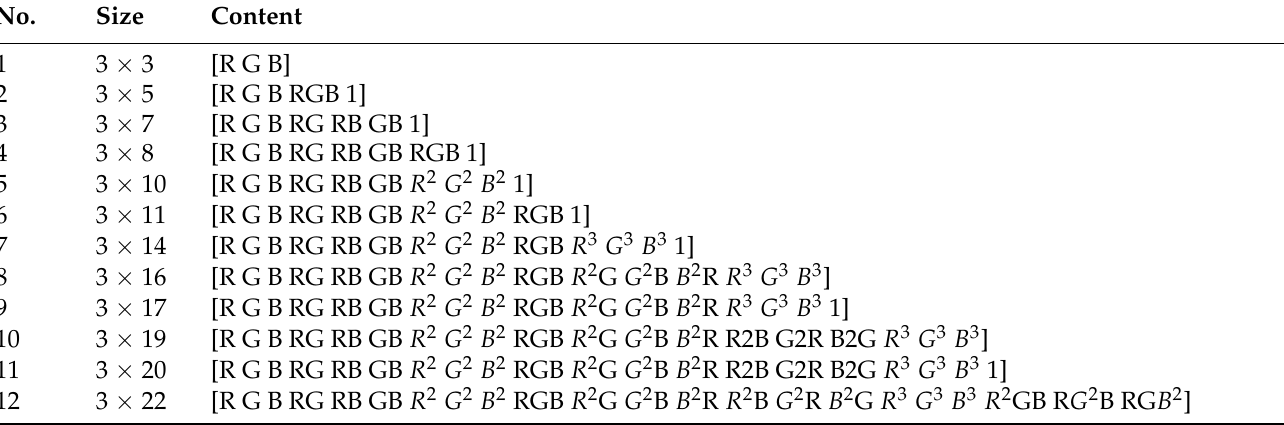
Table 1. Overview of different (higher-) orders of (nonlinear) polynomials to be tested in the applied matrix transformation of Equation (6) according to Hong et al. [126] and Cheung et al.